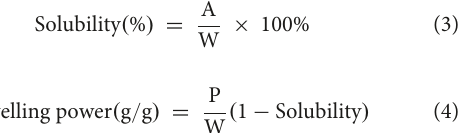
where M 1 ( µ g) represents the phosphorus content of the sample solution determined from the standard curve, V 0 (mL) represents the volume of the sample solution, M 0 (g) represents the mass of the test sample and V 1 (mL) represents an equal volume of sample solution for